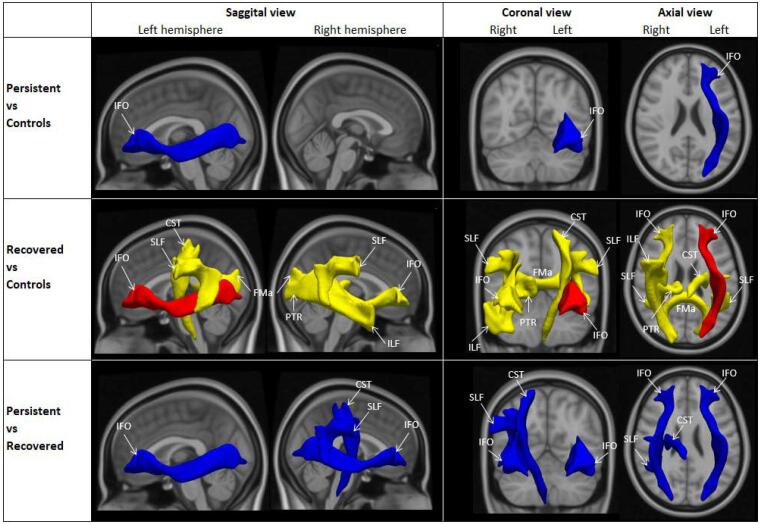
White matter tracts differences associated with stuttering, in mean diffusivity (MD). CST = corticospinal tract, FMa = forceps major, IFO = inferior fronto-occipital, ILF = inferior longitudinal fasciculus, SLF = superior longitudinal fasciculus, PTR = posterior thalamic radiation, red = positive, did not survive FDR; yellow = positive, pFDR < 0.05; dark blue = negative, did not survive FDR; light blue = negative, pFDR < 0.05.